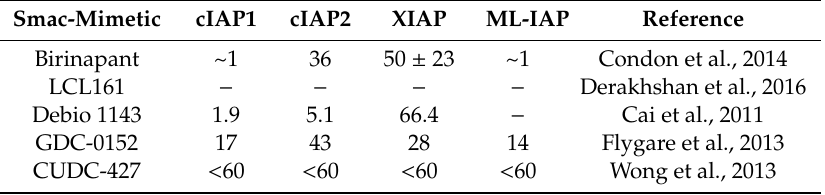
Table 1. K i (nM) values for clinically relevant Smac-Mimetic